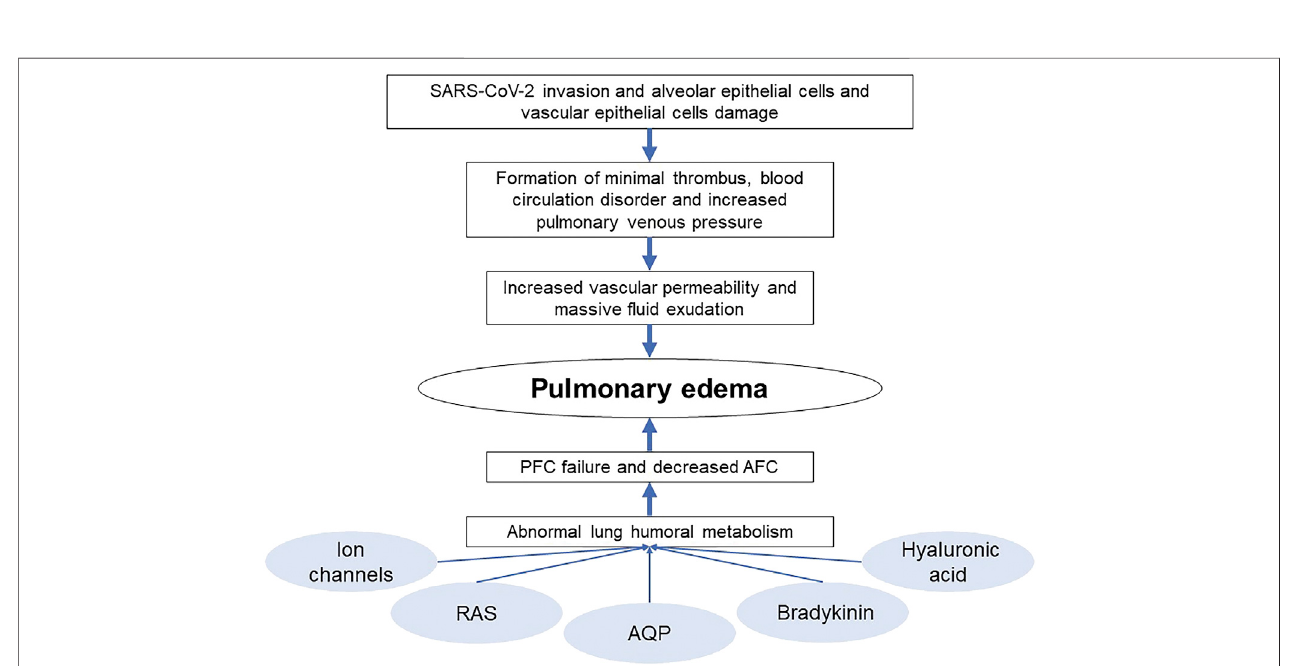
FIGURE 3 | Cause of COVID-19 pulmonary